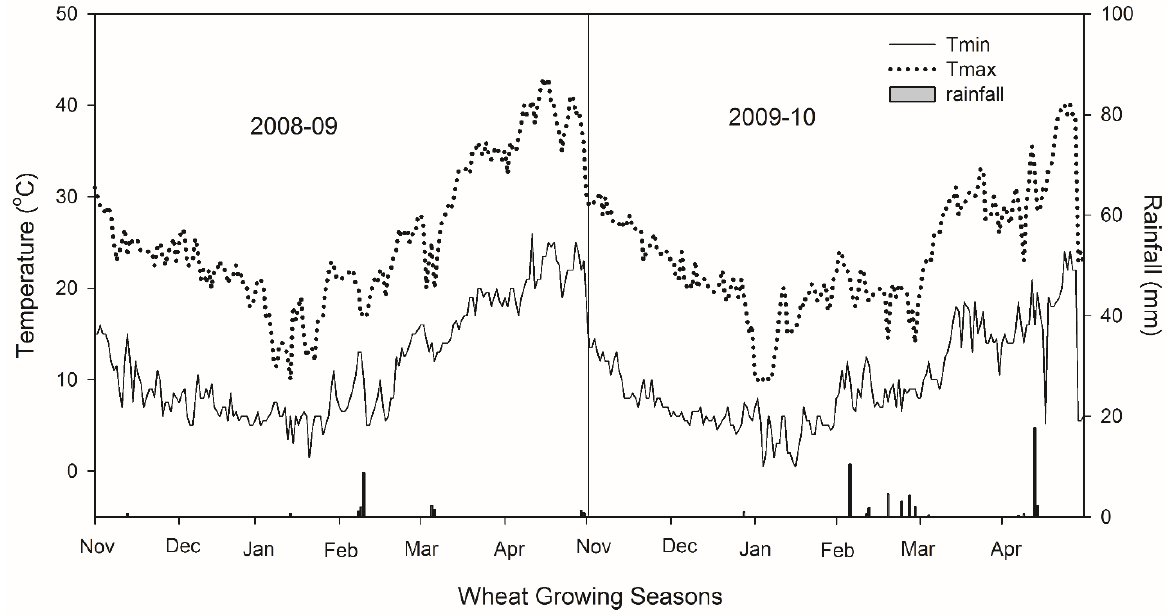
Figure 1. Mean minimum and maximum temperature and rainfall at Faisalabad during the 2008–2009 and 2009–2010 wheat growing seasons.